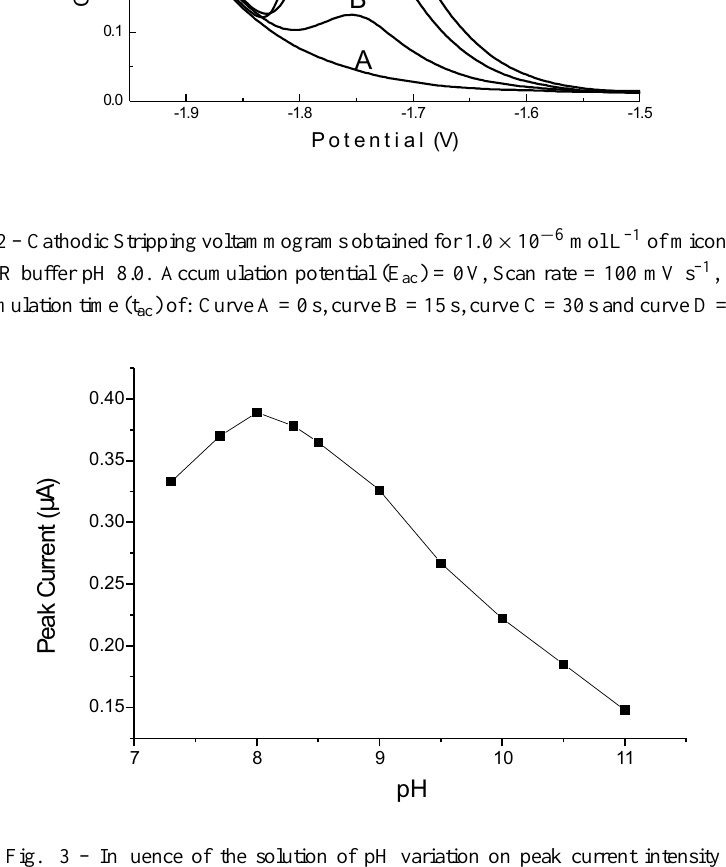
Fig. 3 – Influence of the solution of pH variation on peak current intensity obtained from cathodic stripping voltammograms of 1 . 0 × 10 − 6 mol L –1 mi- conazole. E ac = 0V, t ac = 60s and ν = 100 mV s –1